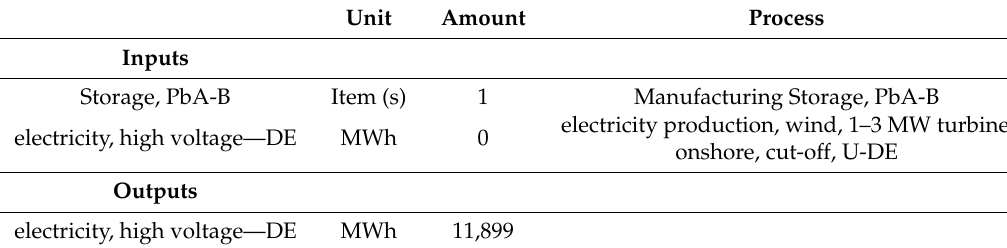
Table A20. Use Storage,